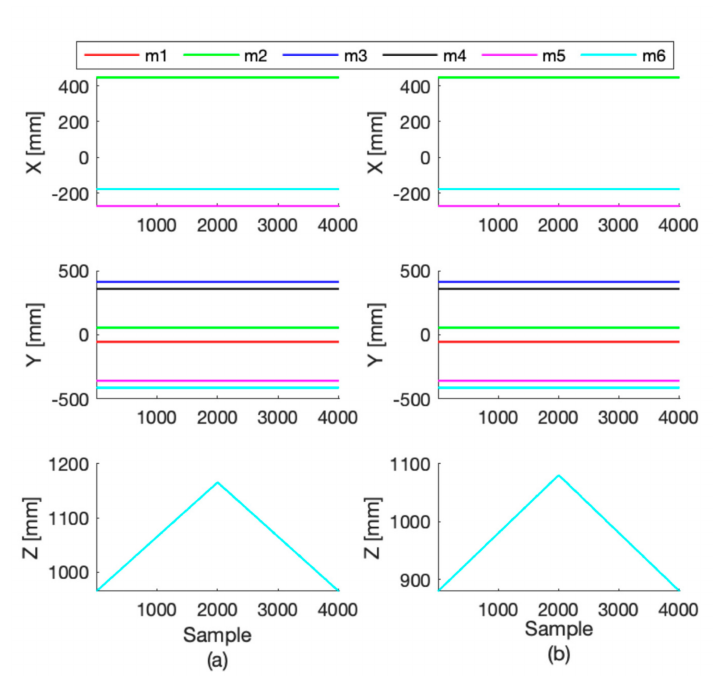
Figure 6. Cartesian coordinates of the connecting points of the mobile plate m i (one color each point) while it is elevating from the floor up to 200 mm (first test). ( a ) Data captured by the cameras system. ( b ) Platform data.